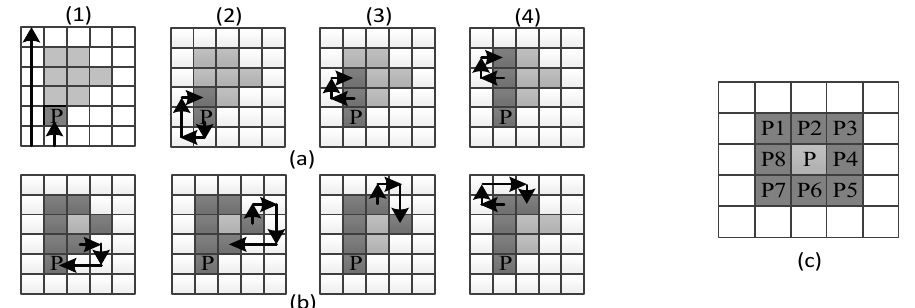
Figure 6. Moore–Neighbor (MN) algorithm demonstration, ( a ) starting steps for MN algorithm; ( b ) last steps for MN algorithm including stopping criterion; ( c ) Moore neighborhood of a pixel P.